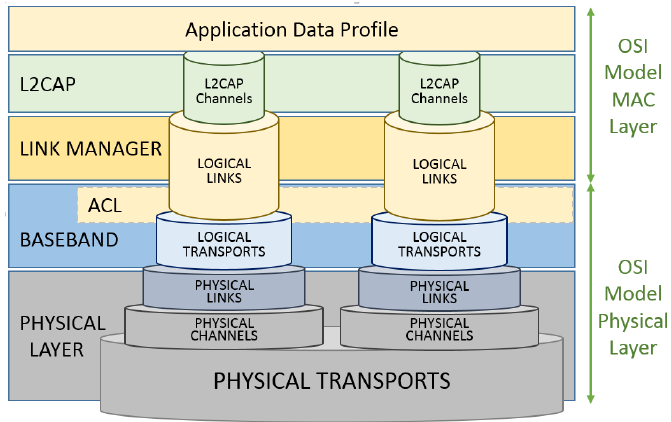
Figure 6. Bluetooth data link